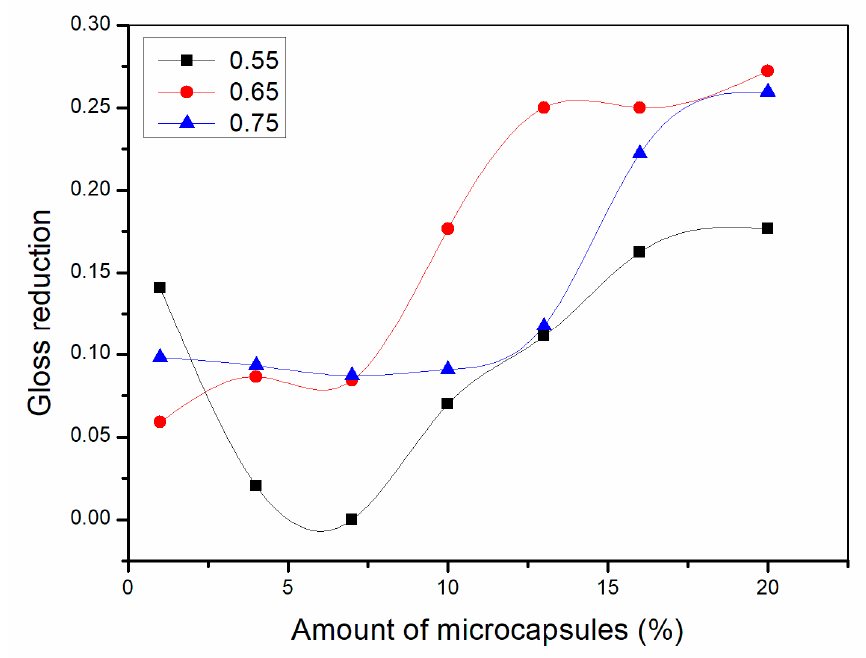
Figure 11. Gloss reduction the coating after drying at 160 °C for 2 h.